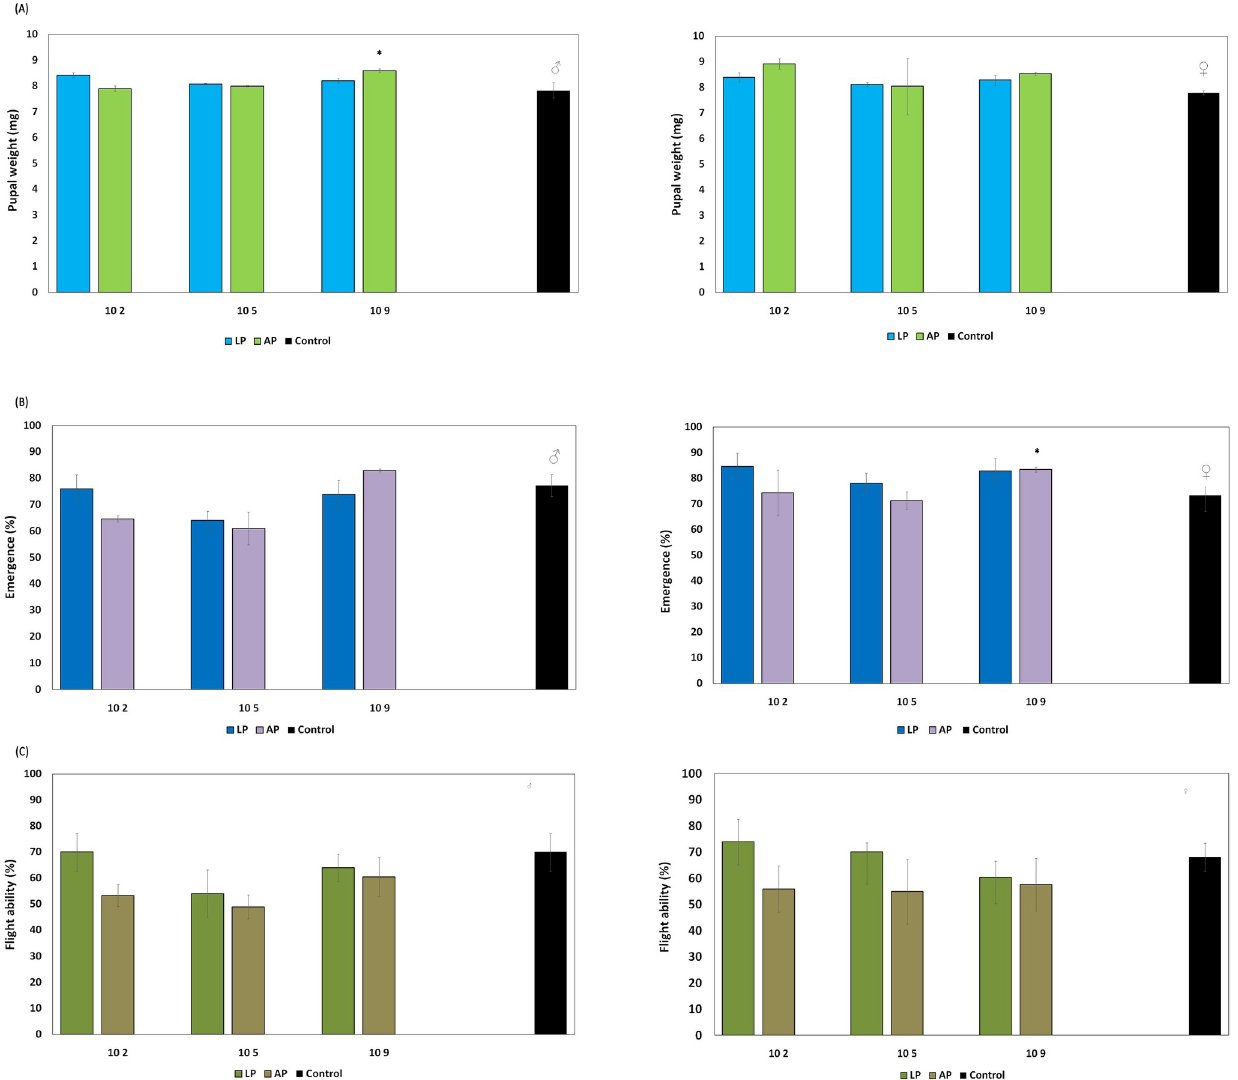
Fig 4. Pupal weight (A) emergence (B) and flight ability (C) quality control parameters of sterile medfly males and females treated with live (LP) and autoclaved (AP) probiotic at three concentrations 10 2 , 10 5 and 10 9 . Standard errors across replicate trials are plotted in the graph. Symbol ( � ) indicates statistical differences (P � 0.05) observed for between